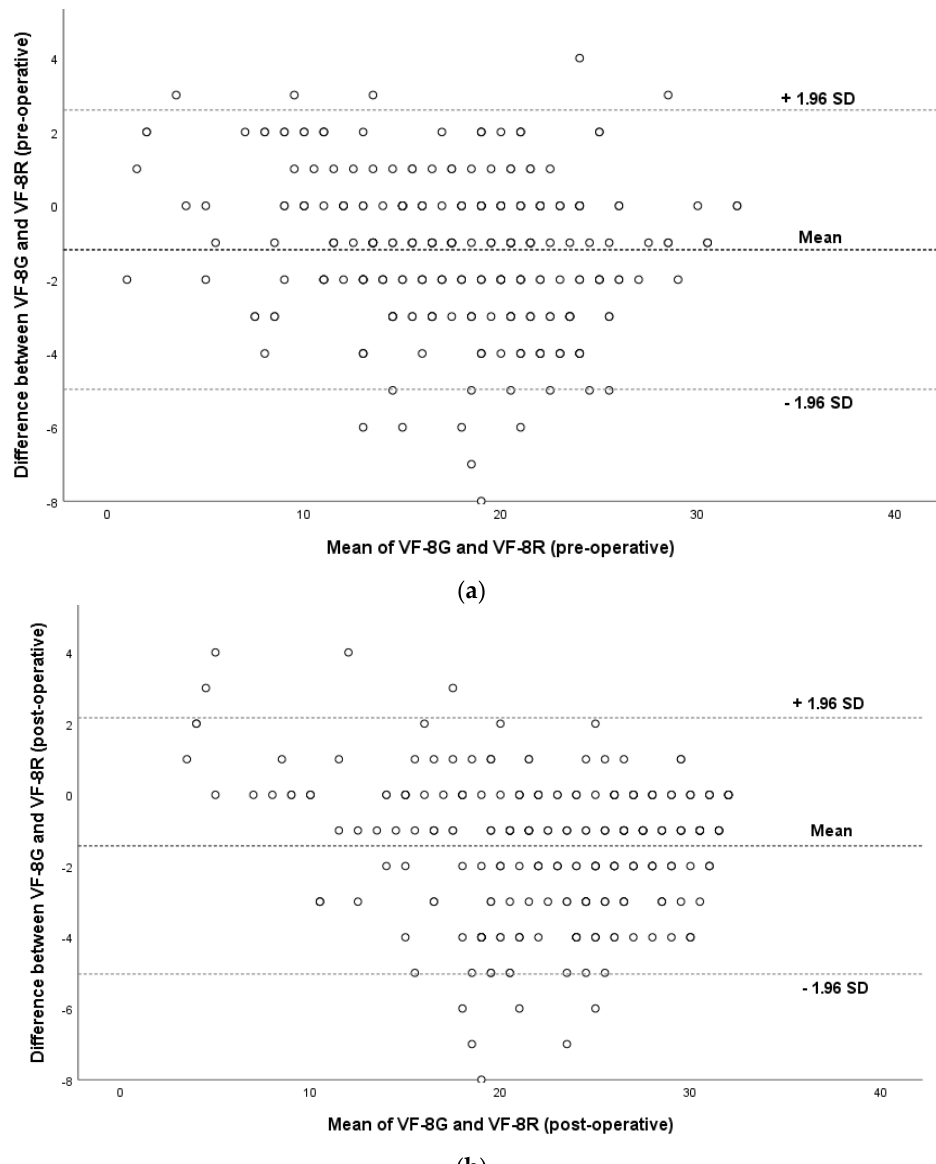
Figure 3. ( a ). Bland-Altman plot of agreement between the Gothwal et al. [5] 8-item VF-8R and the Greek version VF-8G pre-operatively. ( b ). Bland-Altman plot of agreement between the Gothwal et al. [5] 8-item VF-8R and the Greek version VF-8G post-operatively.